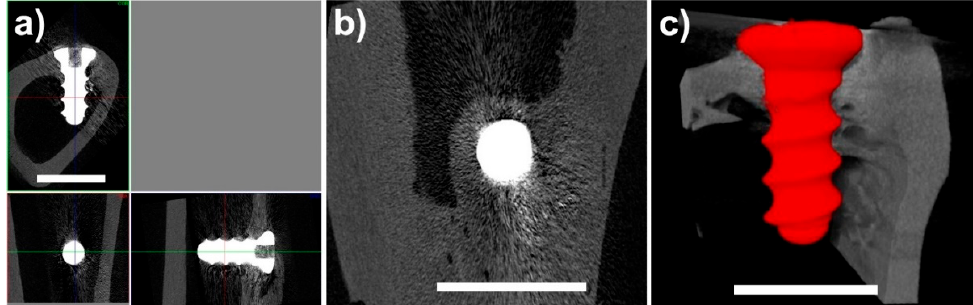
Figure 2. Micro ‐ CT visualizations; ( a ) standardized cross ‐ sectional images in 3 perpendicular planes; ( b ) implant surrounded by bone; ( c ) 3D visualization of implant 240 days after healing. Scale bar = 4 mm.